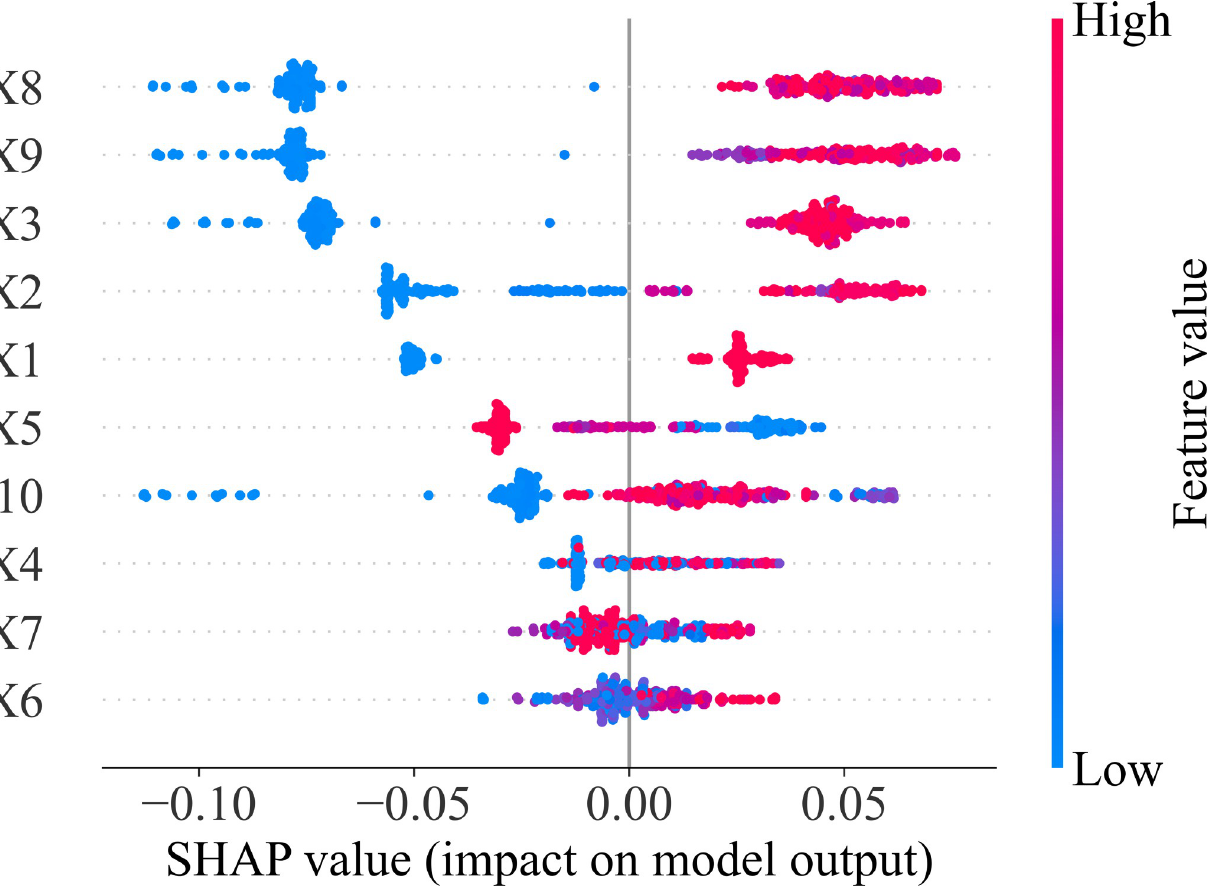
Fig 13. Feature importance of 10 variables used in this investigation.